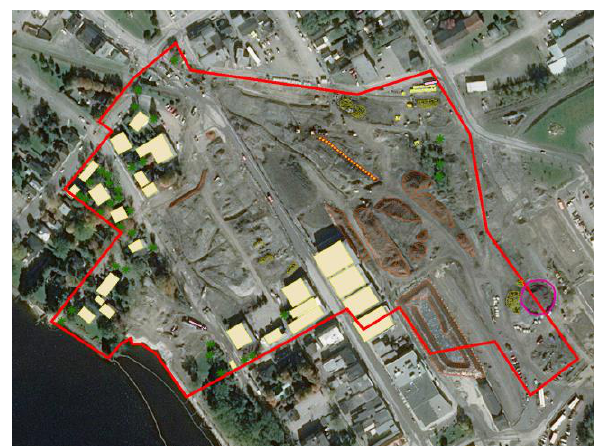
Figure 14. This Pléiades image acquired on September 30,